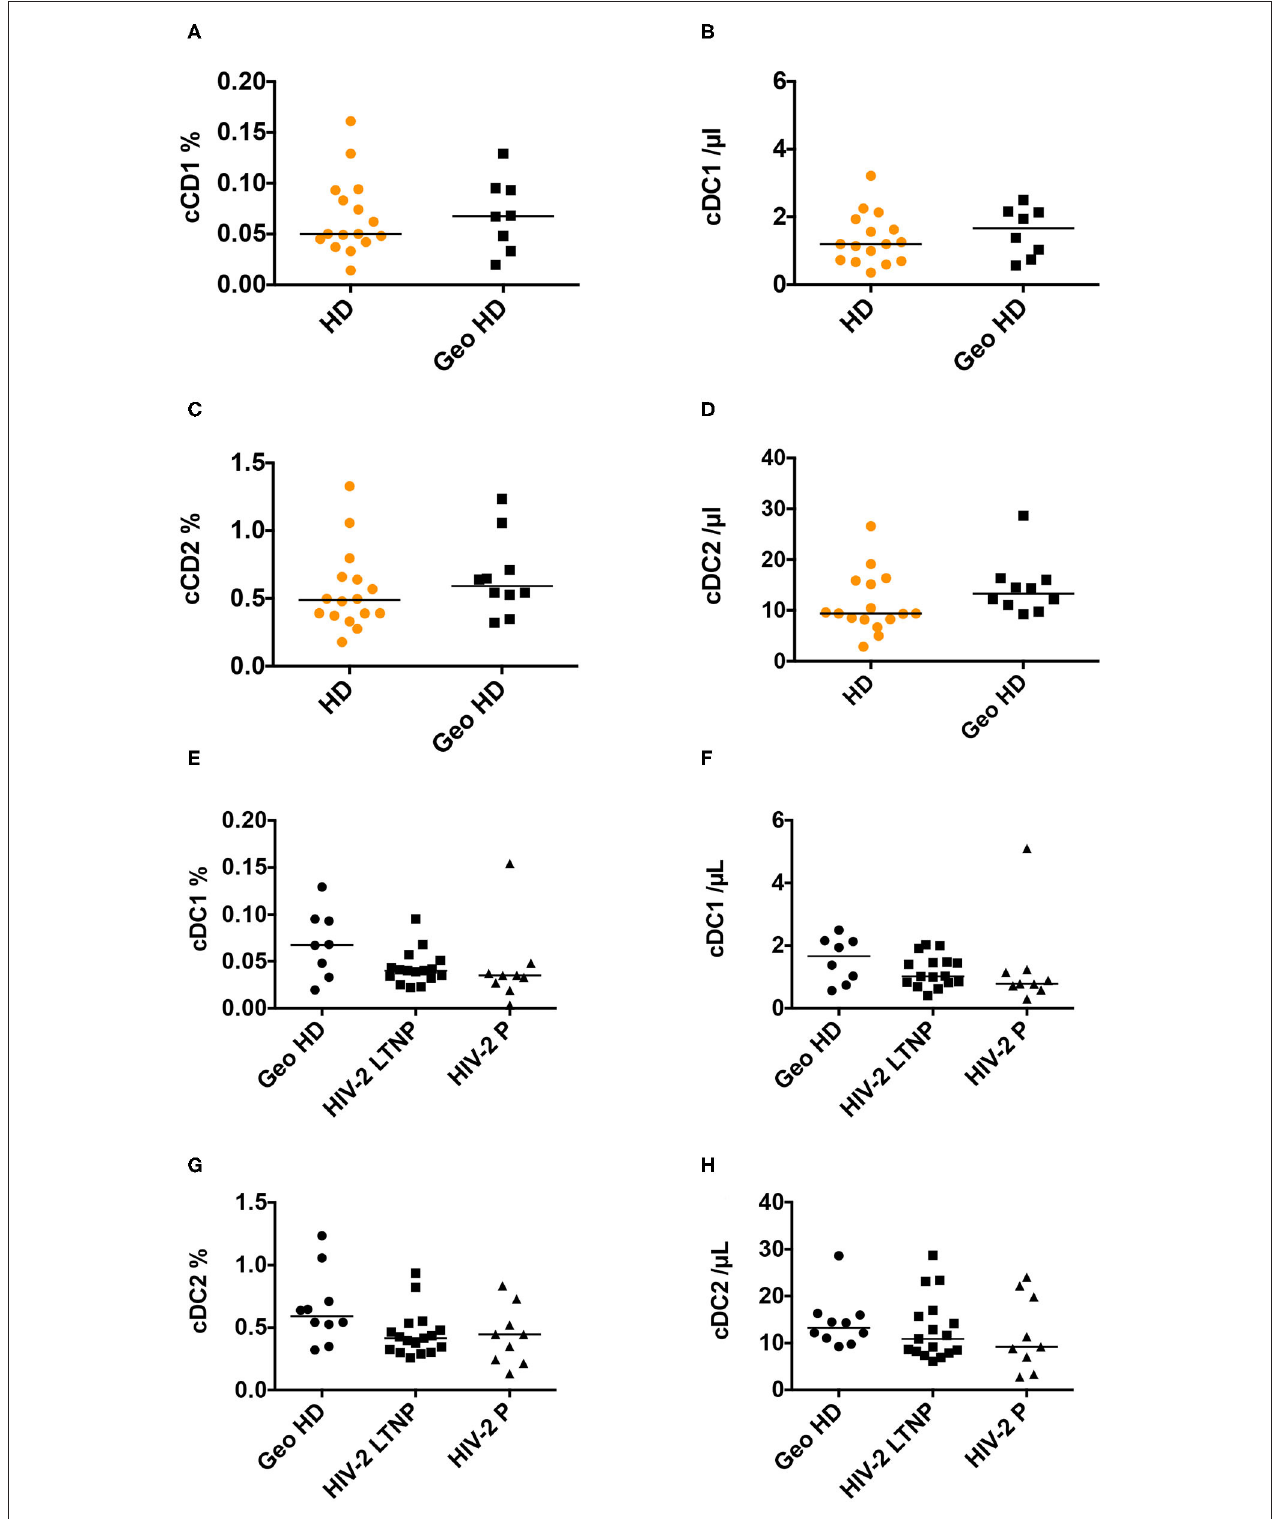
FIGURE 3 | Conventional cDC1 and cDC2 percentages among CD45 + PBMC and absolute counts. (A) Conventional DC1 percentages among CD45 + PBMC and (B) absolute counts/ µ L blood, (C) cDC2 percentages and (D) absolute counts/ µ L blood, in HD and GeoHD. Orange: unknown origin, Black: West-African origin. (E) cDC1 percentages and (F) absolute counts, (G) cDC2 percentages and (H) absolute counts, in GeoHD, HIV-2 LTNP and P, all of West-African origin. Horizontal bars represent median values. Mann-Whitney tests, Kruskall-Wallis tests and descriptive statistics can be found in Table 3 (in italics for West-African participants).